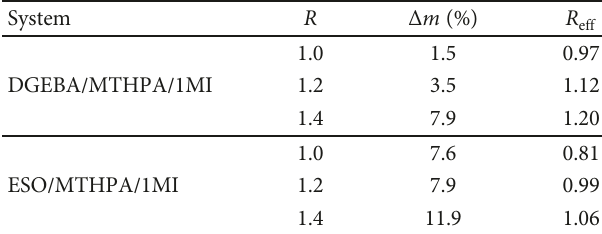
Table 2: Kinetics parameters of the DGEBA/MTHPA/1MI and ESO/MTHPA/1MI systems with di ff erent stoichiometric ratios R .